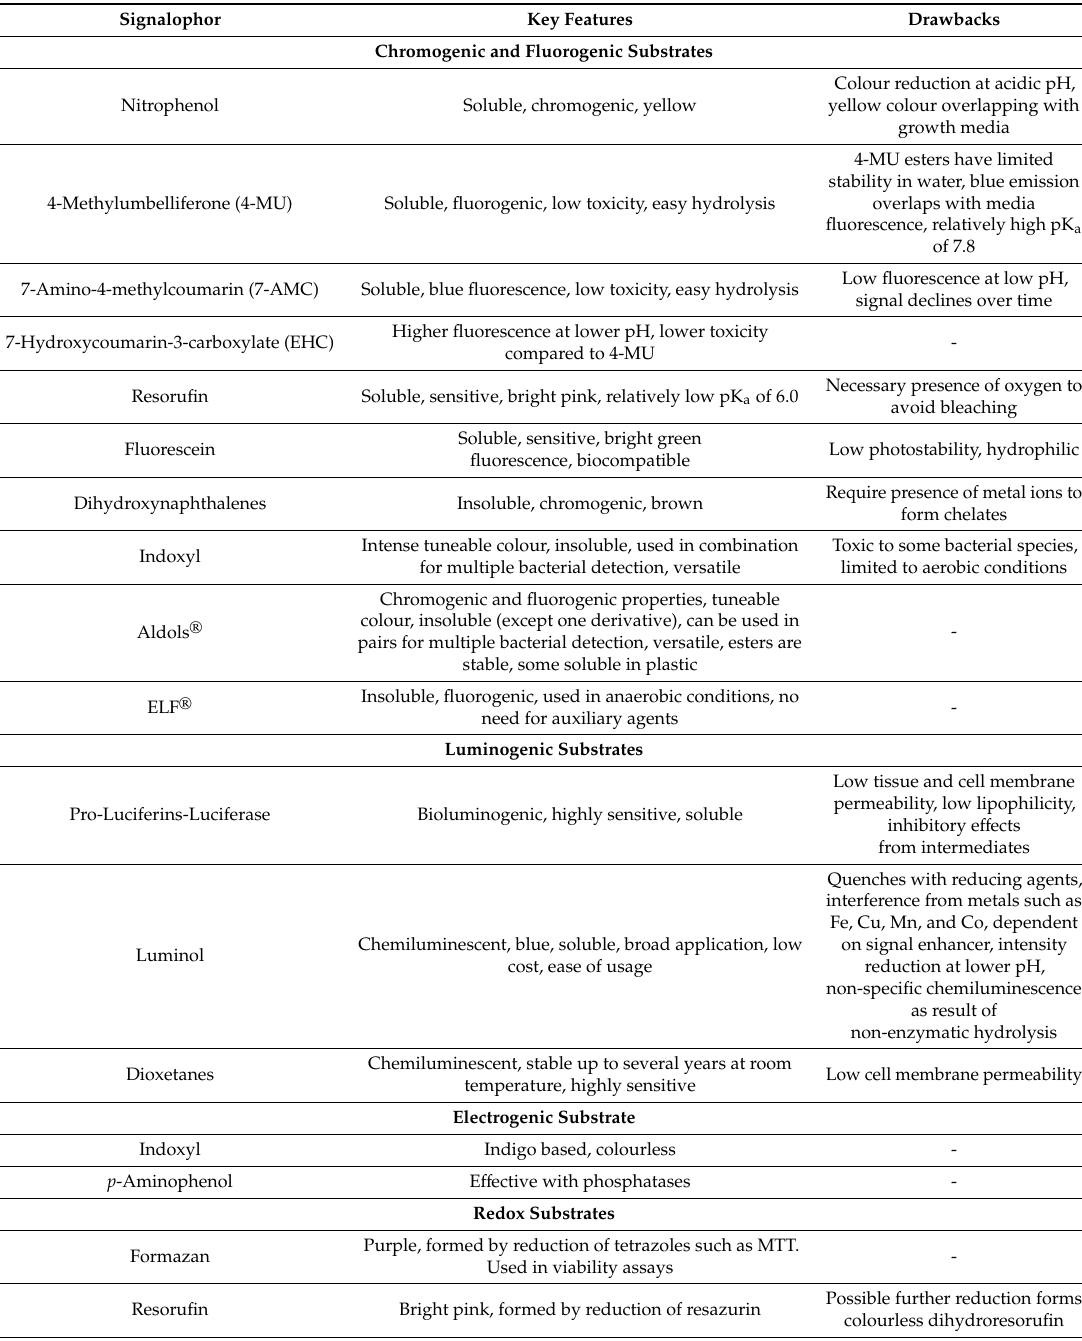
Table 1. Key features of modified